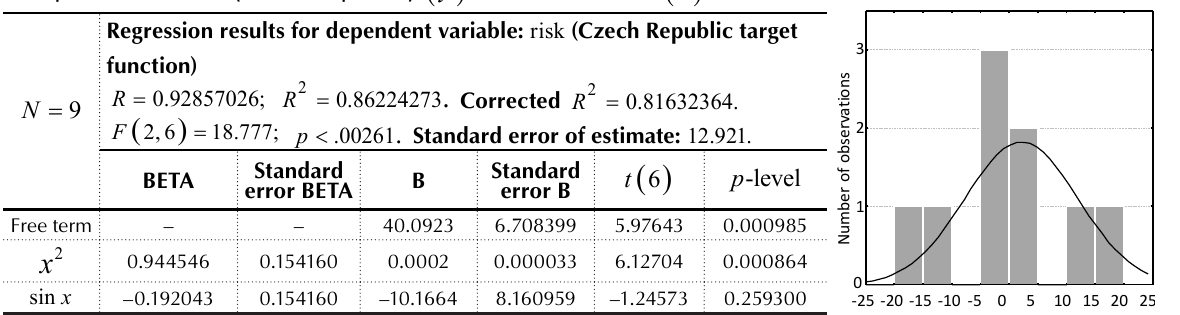
Table 3a. The results of regression for the standard deviation of the size of the Investor Compensation Fund (Czech Republic)